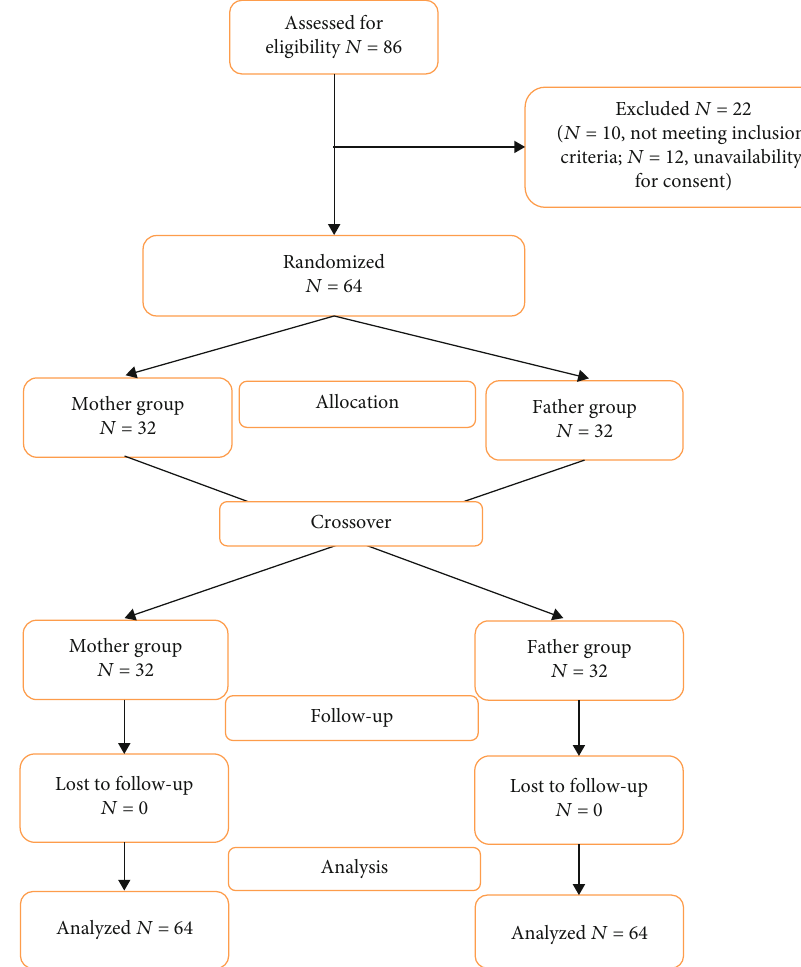
Figure 1: Participant fl ow